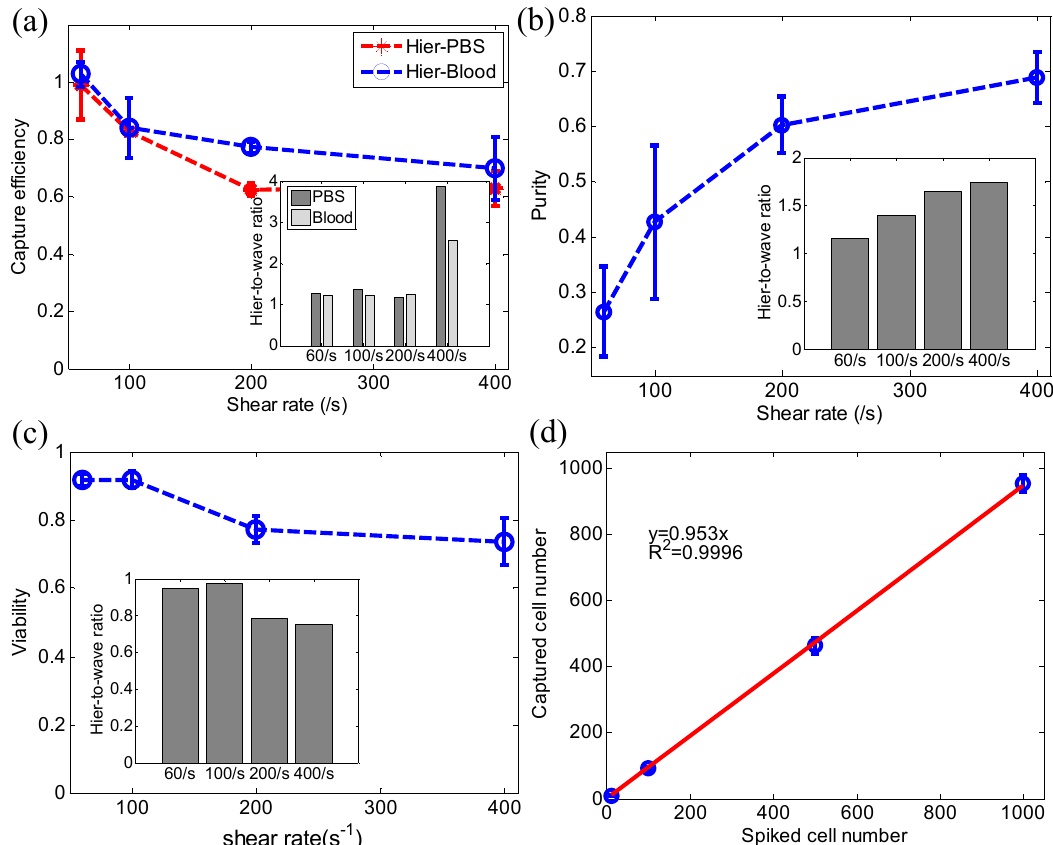
Figure 5. Performance of the hierarchical wavy-HB chip in comparison to the pure wavy-HB chip. ( a ) Capture efficiency vs. shear rate in the hierarchical wavy-HB chip from both PBS buffer and whole blood. ( b ) Purity vs. shear rate in the hierarchical wavy-HB chip. ( c ) Viability vs. shear rate in the hierarchical wavy-HB chip. ( d ) Captured cell numbers in experiments with PBS spiked with a different number of CTCs. The insets in (a)-(c) show the ratio between the hierarchical wavy-HB chip and the pure wavy-HB chip. Error bars indicate the standard deviation from three independent experiments.